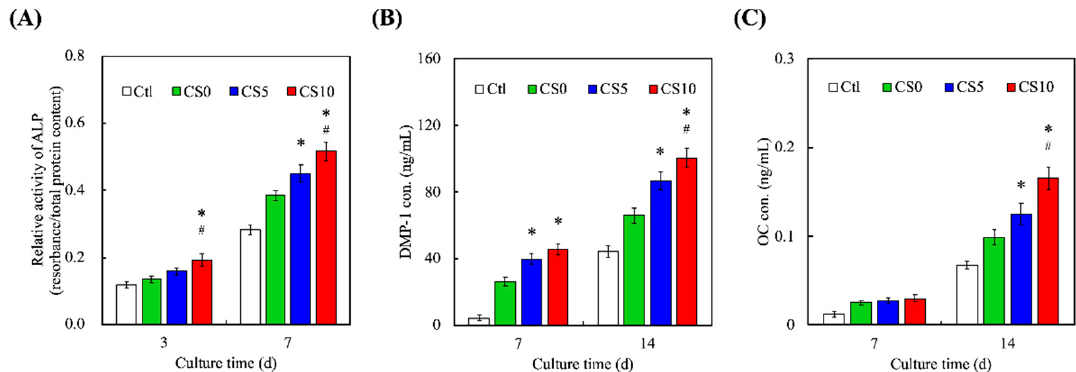
Figure 9. Expressions of ( A ) ALP, ( B ) DMP-1 and ( C ) OC of hDPSCs-laden CS/GelMa scaffolds for different time-points. * = significant difference as compared to CS0 and # = significant difference as compared to CS5 ( p < 0.05). Data are presented as mean ± SEM, n = 6 for each group.